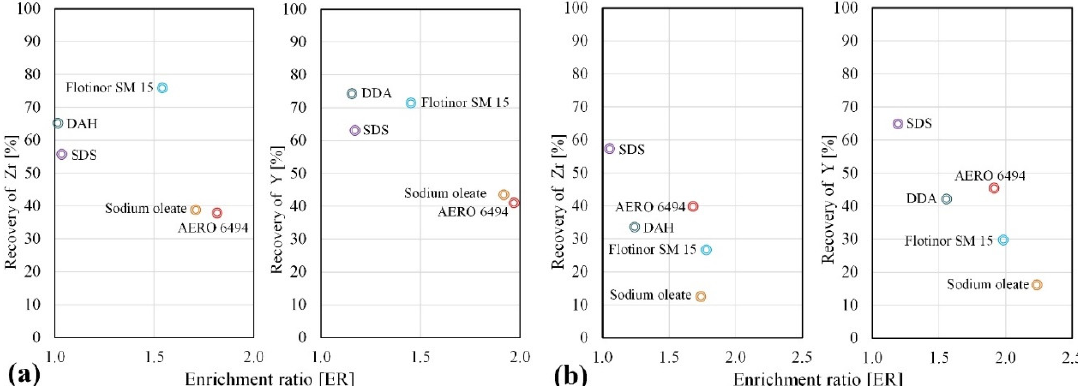
Figure 5. Selection of collectors for the selective flotation of zirconosilicates at the pH of 7 ( a ) and 10 ( b